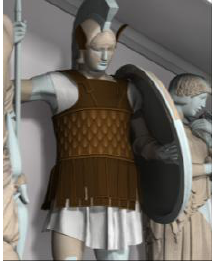
Figure 13. The spear-heads of the male figures in the closed arrangement